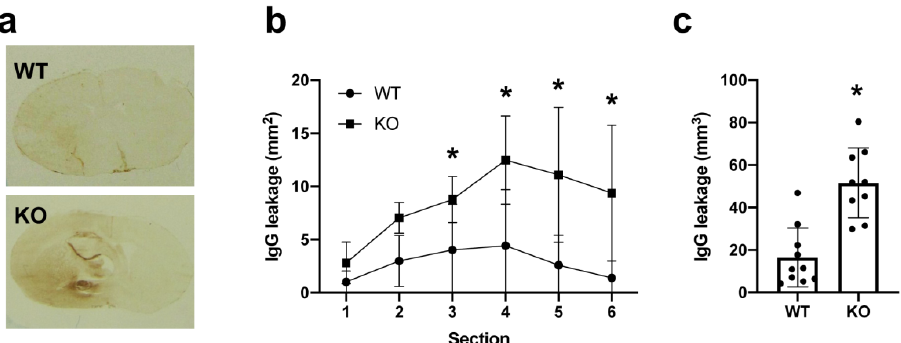
Figure 2. BBB leakage after stroke in mice: Akap12 KO mice or wild type (WT) mice were subjected to transient MCAO, and 3 days later, they were sacrificed for IgG staining. In WT mice, more IgG leakage was observed in the ipsilateral side compared to the contralateral side. In addition, KO mice showed exacerbated BBB damage, as assessed by IgG positive area. ( a ) Representative IgG staining images. ( b ) Quantitative results of IgG leakage in each brain section. Mean + SD of n = 9–10 per group. * p < 0.05 vs. WT for individual section. Two-way ANOVA followed by post-hoc Sidak’s multiple comparisons test. ( c ) Quantitative results of IgG leakage. Mean + SD of n = 9–10 per group. * p < 0.05 vs. WT. Mann-Whitney